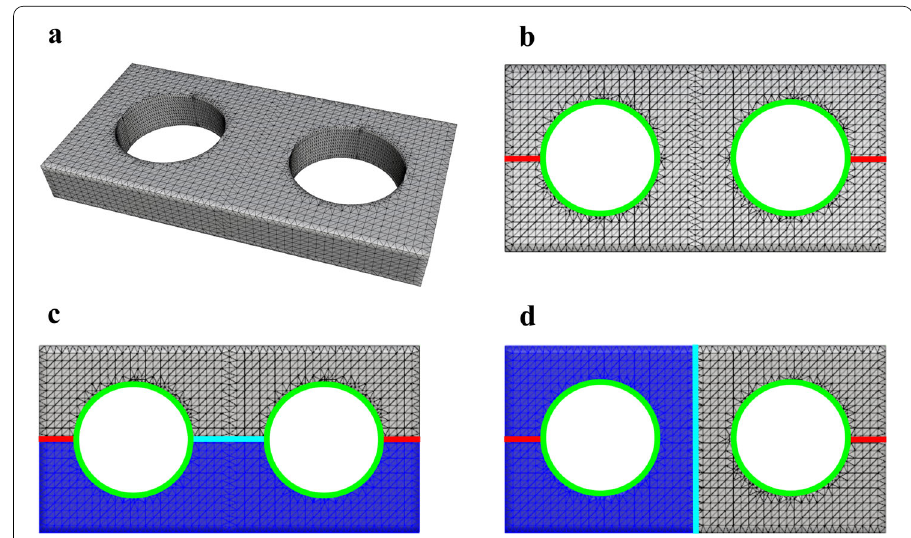
Fig. 4 Genus-2 plate pants decomposition. Triangulated surface ( a ) with its handle and tunnel loops in red and green, respectively ( b ). Pants decomposition using loops with shortest distance ( c ) and with symmetry